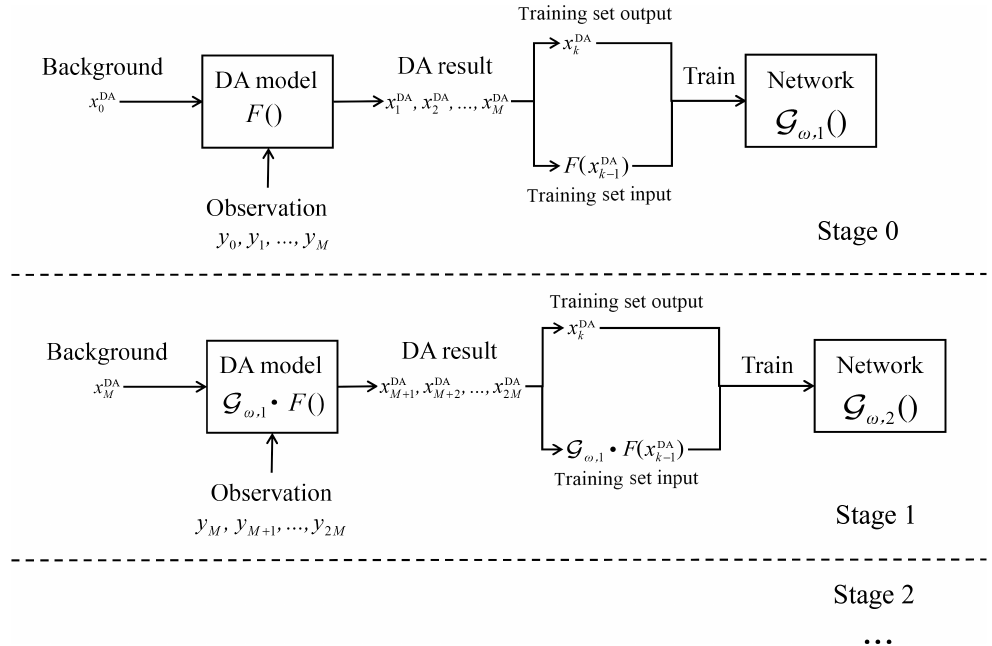
Fig. 1 Schematic diagram of